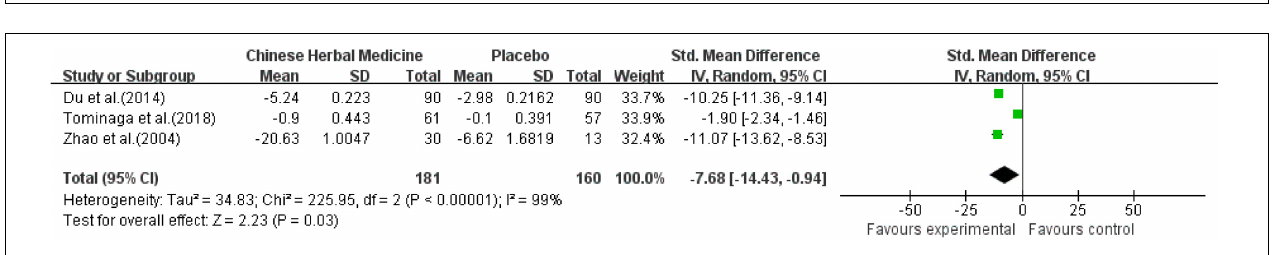
FIGURE 6 | Meta-analysis of total symptom score of CHM and placebo.